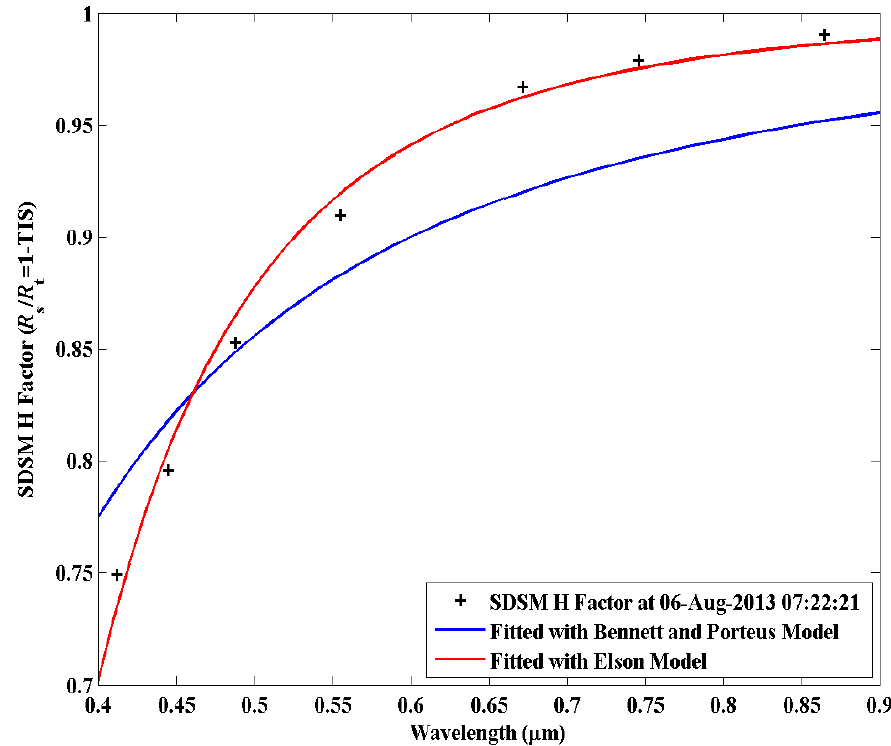
Figure 5. Applying Bennett and Porteus (Equation (4)) and Surface Roughness based Rayleigh Scattering (SRRS) model to fit for spectral dependent degradation of VIIRS SD.